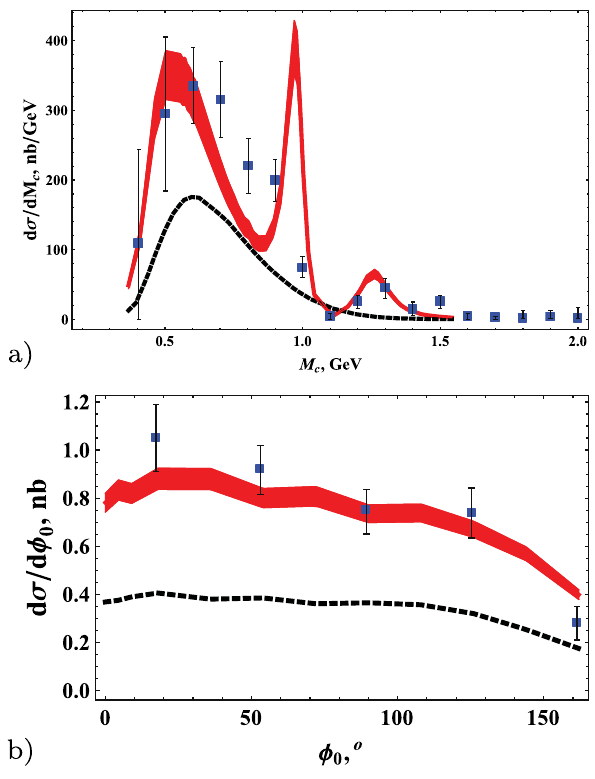
Fig. 5 The data on the process p + p → p + π + + π − + p at √ s = 200 GeV (STAR collaboration [21,22]): a | η π | < 1, | η ππ | < 2, p T π > 0 . 15 GeV, 0 . 005 < − t 1 , 2 < 0 . 03 GeV 2 ; b plus additional cut M c < 1 GeV. Curves correspond to Λ π = 1 . 2 GeV in the off-shell pion formfactor(11)andcouplingsfrom(14).Soliduppercurvescorrespond to the sum of all amplitudes, and dashed lower curves represent the continuum contribution. The thickness of the solid curves corresponds to the errors of Monte Carlo calculations. Additional interpolation was used between calculated points for smoothing